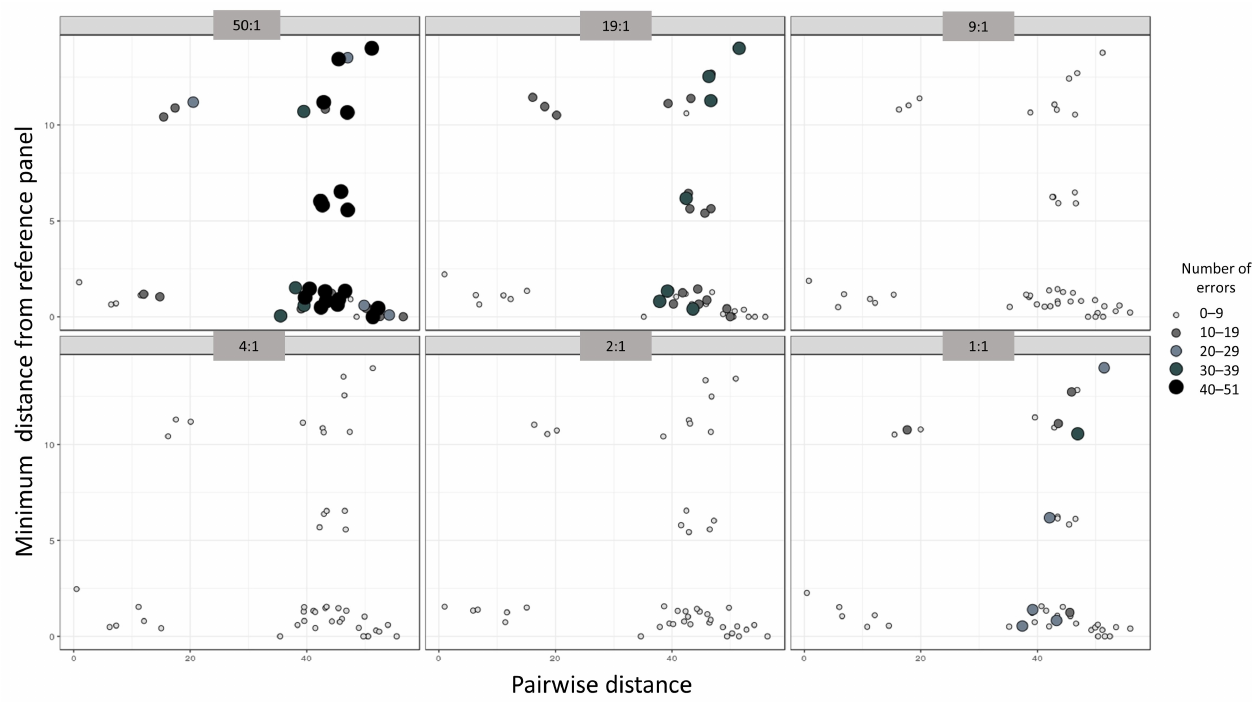
Figure 4. Scatterplot depicting the relationships between the accuracy of phasing in the number of haplotype estimation errors (size and color of the dots), the pairwise distance between the mixed haplotypes ( x -axis), and the minimum distance from the reference panel ( y -axis). Each individual panel represents a mixture